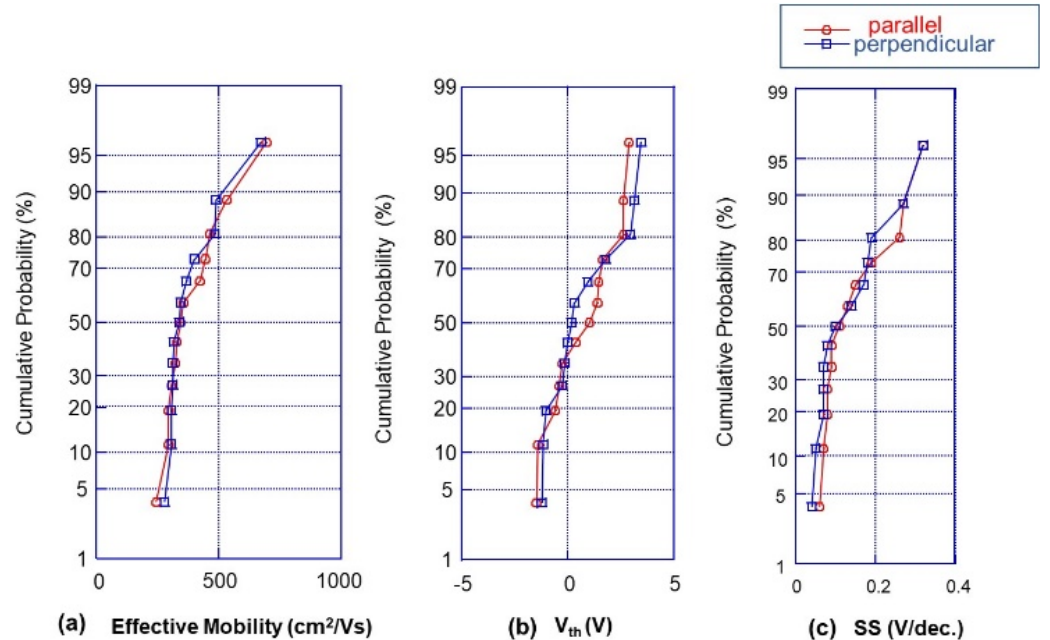
Figure 7. Cumulative distributions of electrical characteristics for the parallel and perpendicular TFTs having channel regions made in GB-free stripes. L = 10 µ m, and W = 5 µ m. ( a ) Effective field-effect mobility, ( b ) threshold voltage V th (V), and ( c ) subthreshold swing SS (V/dec).